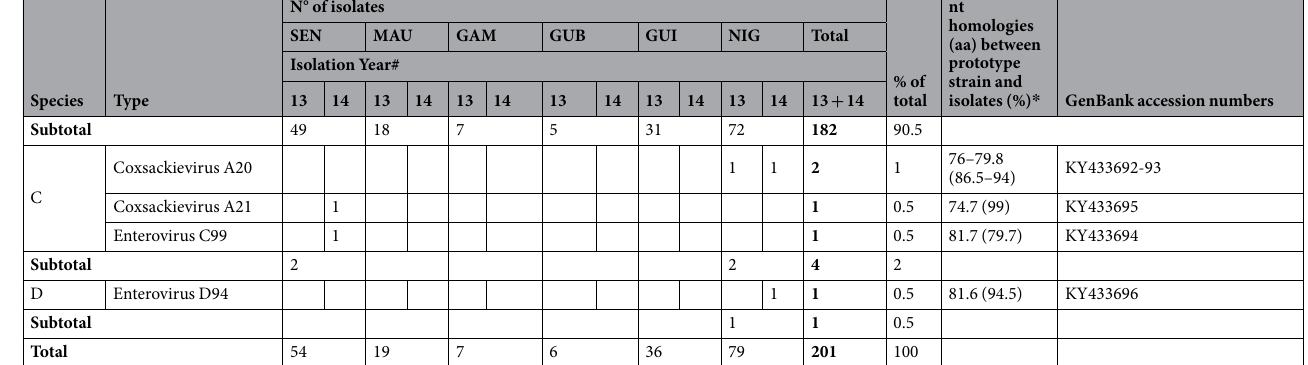
from 9.9% in Guinea to 15.3% in Mauritania (Table 1). The prevalence of EV-A, EV-B and EV-C infections was similar in 2013 and 2014 (8.3% vs 5.7%, 90.6% vs 89.6% and 1% vs 2.8%, respectively). Of the 39 different types (Table 2). CVB4, CVB5, E6, E7, E11, and E24 circulated more frequently during 2013 (7.3–11.5%), while E1, E13 and E19 were found more commonly in 2014 (6.6–10.4%). Strains belonging to EV-A and EV-B species were more frequently observed in Niger (28.5% and 39.3%, respectively), Senegal (21.4% and 26.7%, respectively) and Guinea (35.7% and 17.4%, respectively) probably because of the higher number of samples from these countries or higher circulation of those species (Table 2). Strains belonging to EV-C species were rarely observed, with one CVA21 and one EVC99 in Senegal and two CVA20 in Niger. Majority (3/4, 75%) were detected in samples from 2014. Only one strain from EV-D specie (EVD94) was found in Niger in 2014. The more geographically expanded types of NPEV strains included E24 (only type found in the six countries), CVB4, E3, E7 and E20 that were pres- ent in at least five countries. Types more frequently observed per country were E6 and E13 in Niger (n = 9 and n = 10 respectively), E1 and E13 in Senegal (n = 6 and n = 5, respectively), E11 and CVB4 in Mauritania (n = 4 and n = 3, respectively), E24 and CVB5 in Guinea (n = 3 for both) (Table 2). Although NPEV positive AFP cases were detected throughout the 2 years of study, seasonal variation was observed. NPEV infections showed a lower incidence from October to February (begin of dry cold season) (positivity rate range of 2.1–8.5%), while two inci- dence peaks were observed: one in March-April (end of dry cold season) (positivity rate of 12% and 12.8%) and other in August-September (rainy hot months) (positivity rate of 11.5% and 12.8%) (Fig. 1). Phylogenetic analysis. Classification of the strains into different types was also demonstrated by construc- tion of phylogenetic trees using aligned partial or complete VP1 sequences. Study specimens of the same type clustered together with the respective prototype strains, supported by high bootstrap values, further confirming type identification (Fig. 2). Phylogenetic analysis of VP1 sequences of strains belonging to the most prevalent types E13 and E6 revealed that all isolates featured a wide range of genetic variability, expressed through segre- gation within different groups and sub-groups. For E13, the type more frequently detected, phylogenetic analysis indicated the existence of 3 different clusters that we designated 1–3 (Fig. 3). Twelve study strains from Senegal, Niger and Guinea fell in a bootstrap-supported cluster (cluster 1) with strains from Central African Republic (CAR) showing mean 89.1% (88.2–90%) nt and 97.5% (96.8–98.2%) aa similarities. The remaining appear to be closely related to E13 strains isolated from 2007 to 2011 in India (cluster 3) exhibiting mean 90.7% (89.9–91.5%) nt and 96.4% (95.6–97.6%) aa similarities. Low intratypic genetic similarity was observed between E13 study strains of both clusters (mean 73.8% (71.7–75.9%) nt and 86.7% (83.6–89.8%) aa homologies). Interestingly, when comparing all NPEV types to their respective homotypic prototype strains, E13 study isolates in cluster 3 were the more distantly related (mean 70.8% (70.1–71.5%) nt and 84.3% (84.1–84.5%) aa homologies) suggesting that these isolates may belong to a new group. However, submission of full P1 (capsid) region sequence to ICTV confirmed these isolates as E13 type (data not shown). Regarding E6, a notable observation was geographical seg- regation of West African strains within group C into the previously assigned sub-groups C5 and C9 10, 11 (Fig. 4). In sub-group C5, strains isolated in Senegal and Guinea clustered together with Algerian strains isolated from AFP cases in 2006 12 with a mean of 10.1% distance between each other and up to 24.4% divergence with the prototype E6 strain D’amori (group A). On the other hand, the nine E6 strains isolated in Niger clustered in sub-group C9 with strains from different countries and continents with a mean 10.8% divergence between each other and up to 23.6% divergence with the prototype (Fig. 4). Other prevalent types of EV-B species such as CVB4, CVB5, E1, E3, E7, E11, E20 and E24, and types of EV-A and EV-C species belonged to several lineages that have already been described for these types (data not shown). The unique EV-D isolate was typed as EVD94. Overall, six isolates of EVD94 have been reported so far, five from sewage in Egypt and one from an AFP case in Democratic Republic